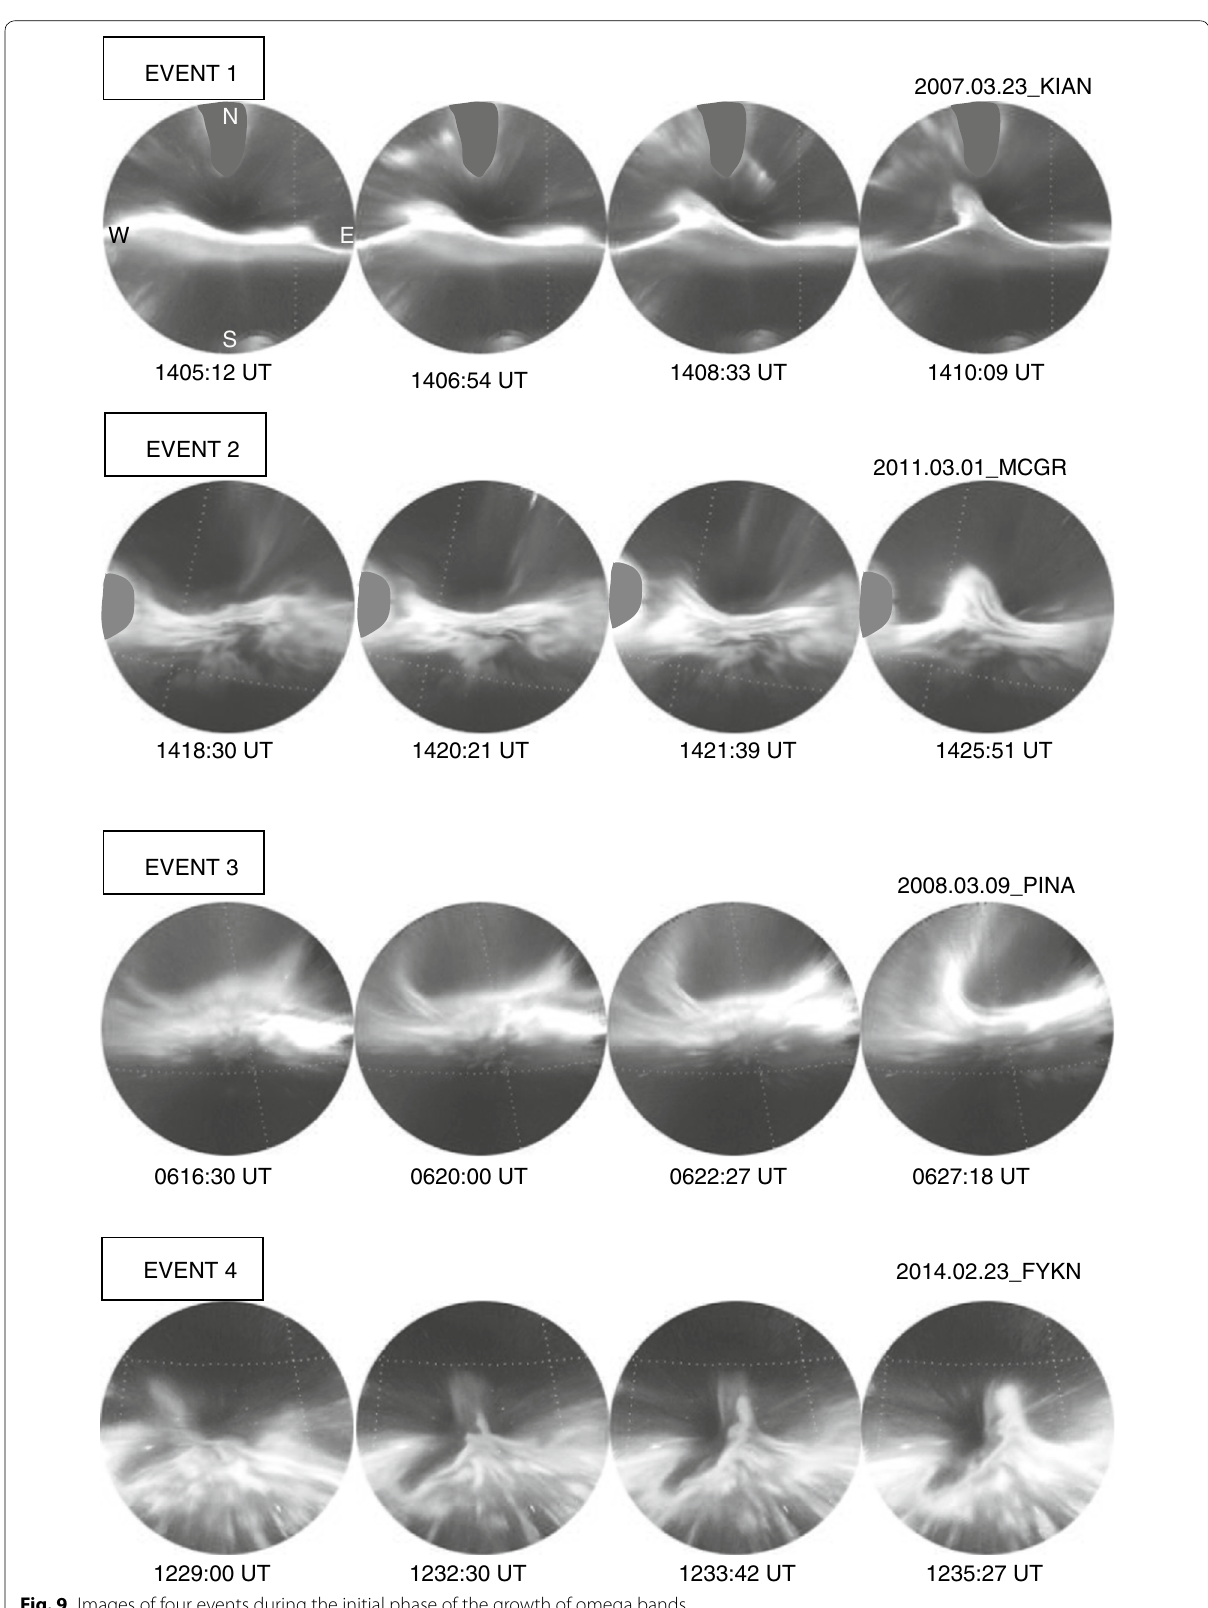
Fig. 9 Images of four events during the initial phase of the growth of omega